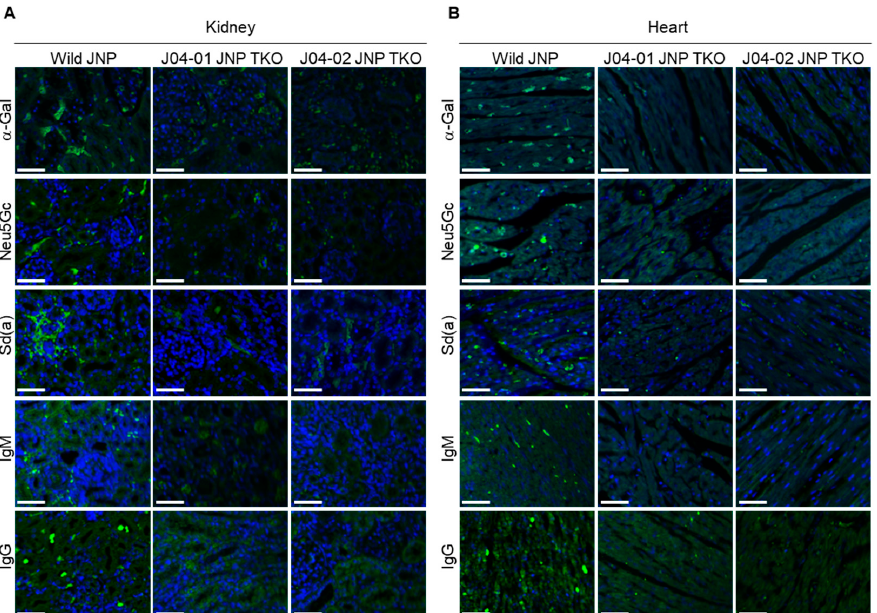
Figure 4. Expressions of α‐ Gal, Neu5Gc, and Sd(a) along with human IgM and IgG antibody binding assays in the kidney and heart of wild ‐ type and TKO JNPs. Immunofluorescence analysis of α‐ Gal, Neu5Gc, and Sd(a) was performed using the kidney ( A ) and heart ( B ) of wild ‐ type and TKO JNPs. In addition, human IgM and IgG binding assays were performed using the kidney and heart tissues. Represented images were overlaid with blue (DAPI) for nucleus and green (Alexa Fluor 488) for target proteins ( α‐ Gal, Neu5Gc, and Sd(a)). Scale bar = 30 μ m.